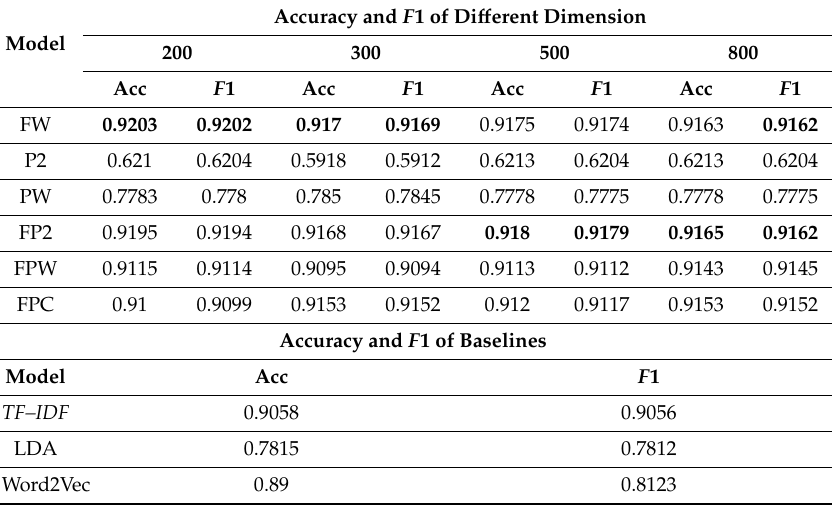
Table 12. Results of books in ChnSentiCorp by